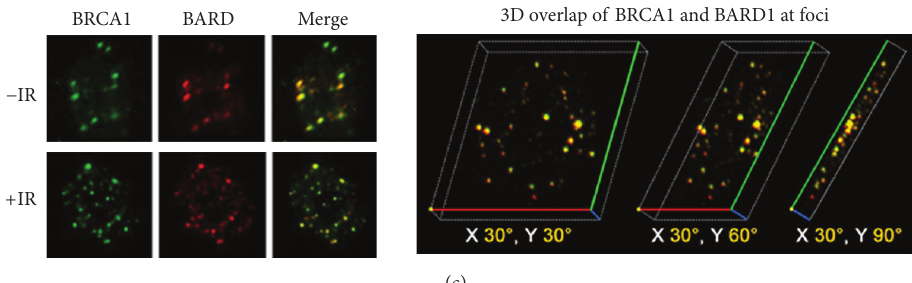
F 2: BRCA1 targeting to centrosomes and nuclear foci. (a) Deletion mapping studies identi�ed the same minimal targeting sequences (the amino and carboxy termini combined) that were required and sufficient to target BRCA1 to nuclear foci [45] and the centrosome [46]. (b) is is illustrated by a summary diagram. (c) BRCA1 is localized to nuclear foci when analysed by immuno�uorescence microscopy. e BRCA1 staining correlates with large visible nuclear spots thought to be DNA replication sites in untreated S-phase cells (see -IR cell images), and redistributes to smaller DNA repair foci aer 3h treatment with 10Gy ionising radiation (+IR). e images shown are of a single cell nucleus and reveal the typical costaining observed between BRCA1 (green) and BARD1 (red), with overlap displayed as yellow (le-hand image). e overlap in staining is also visible in a three-dimensional rotation of the images (right-hand image; adapted from